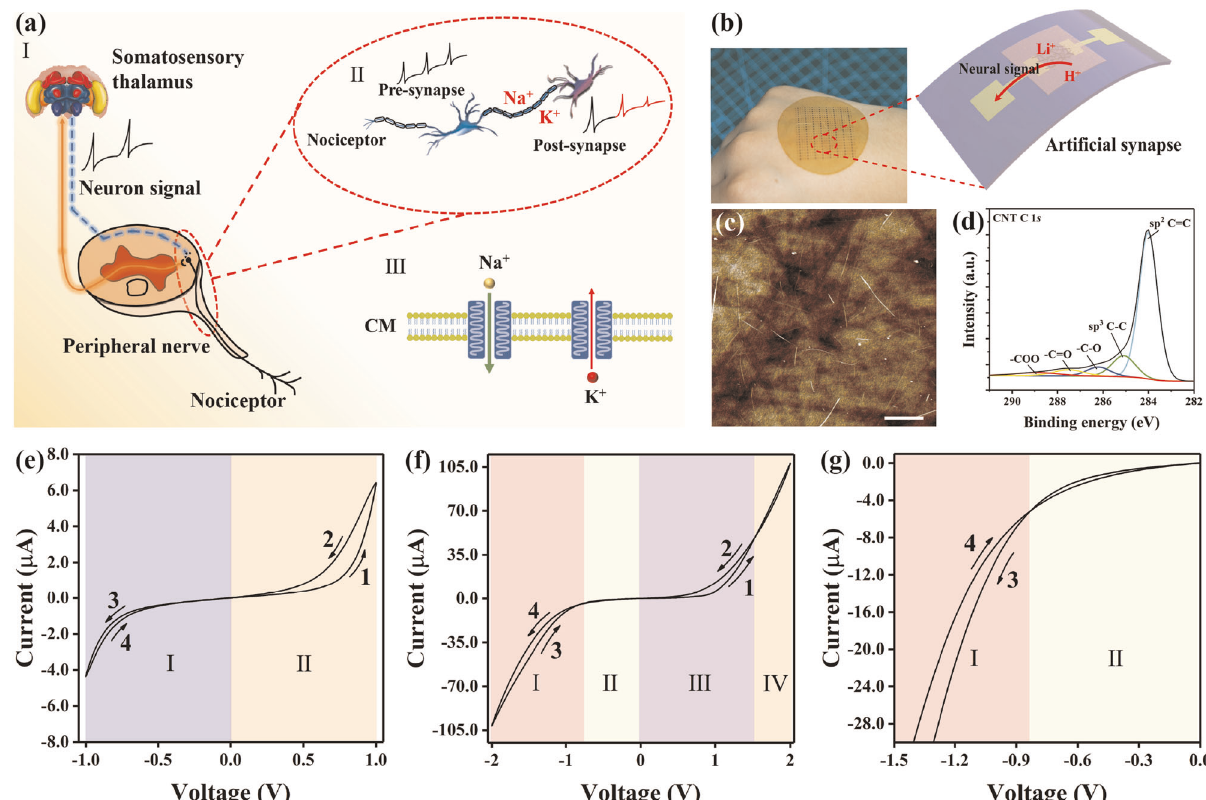
Fig. 1 Design of the bio-inspired double-layer memristor. a The schematic diagram for the pain perception mechanisms of the creature. b The optical image of the memristor-based arti fi cial synapse, in which s-SWCNTs and PEO: LiClO 4 are used as the bottom-layer and top-layer materials, respectively. The protons and Li + mimic the functions of Na + and K + in biological systems. c The AFM image with the length of the scale bar being 1 μ m and d the XPS spectra of s-SWCNTs. The IV characteristics of the arti fi cial synapses with the different sweeping voltages shown in d – f The enlarged IV characteristics in the voltage between 0 V and − 1.5